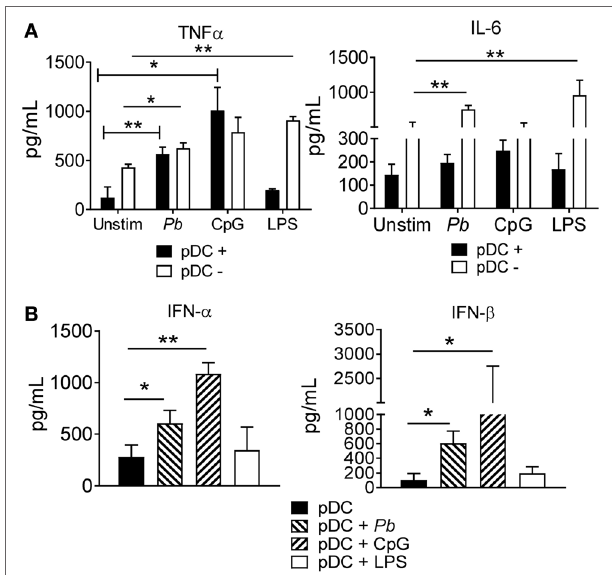
FigUre 2 | Proinflammatory and type I IFNs cytokines released by plasmacytoid dendritic cells (pDCs) stimulated with Paracoccidioides brasiliensis yeast cells. Peripheral blood mononuclear cells (PBMCs) were separated into pDC-positive (pDCs + ) and pDC-negative (pDCs − ) populations using magnetic beads conjugated to anti-CD304 antibodies. The cells (1 × 10 5 /well) were left without stimulation or challenged overnight with of P. brasiliensis yeast cells (2 × 10 3 ), CpG (100 ng/mL), or LPS (10 ng/mL). The supernatant was removed and the levels of IL-6, TNF- α (a) , and type I IFNs (B) were analyzed by ELISA. Data are represented as the mean ± SE of the average cytokine concentrations from five donors, tested in duplicate. *** p < 0.001 by comparing the data indicated by the